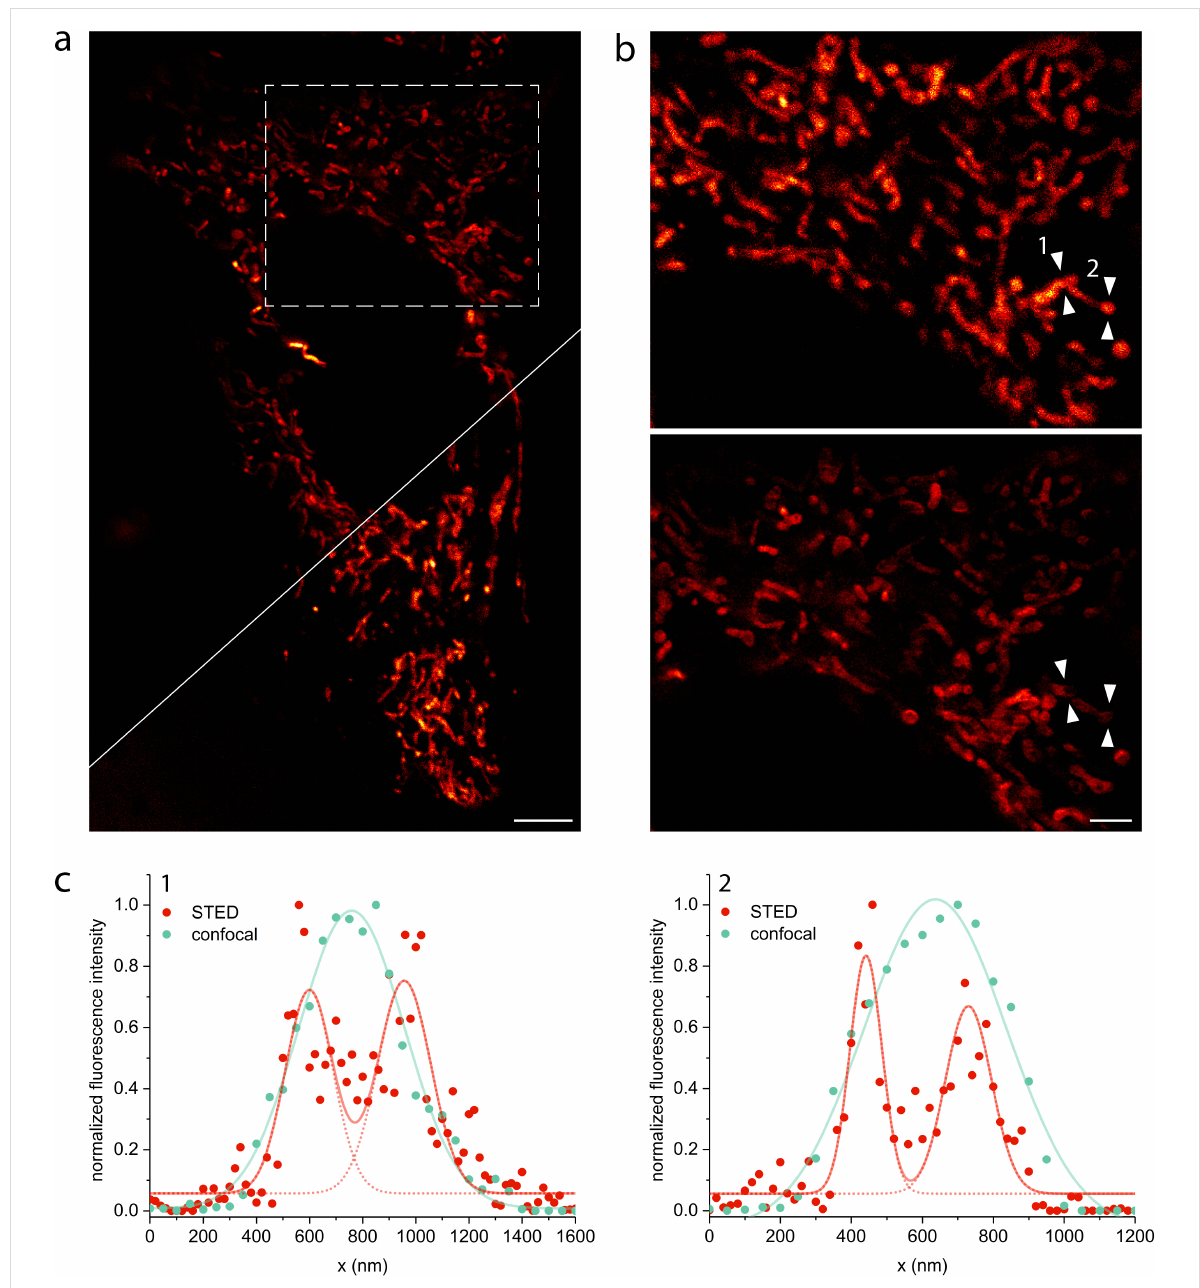
Figure 2: STED and confocal images of the mitochondrial network in living HeLa cells stained with 1 µM SiR dye 15 for 1 h. (a) STED image (excita- tion at 652 nm with 15 µW, depletion at 775 nm with 40 mW) with the corresponding confocal data (excitation at 652 nm with 7.5 µW) in the bottom right corner. STED image is background subtracted and linearly deconvolved (Lorentzian PSF), confocal image is only background subtracted, scale bar 5 µm. (b) Magnified view of the region marked in (a) in confocal (top) and STED mode (bottom), scale bar 2 µm. (c) Line profiles marked in (b) proving the gain in spatial resolution of STED (red) compared to confocal (cyan). Line profiles were taken from only background corrected (not decon- volved) data (Figure S8, Supporting Information File 1), counts were averaged over five pixels, normalized and fitted to a single (confocal) or double (STED) Gaussian function. To avoid photobleaching, the STED power was set as low as possible but as high as necessary to resolve the tubular structure of mitochondria resulting in full width half maxima (FWHM) of 219 ± 15 nm (1, left), 306 ± 21 nm (1, right), 114 ± 7 nm (2, left) and 200 ± 9 (2, right). The peak to peak distances are 363 nm (1) and 294 nm (2). The FWHM of the confocal fits are 470 ± 15 nm (1) and 474 ± 25 nm (2).